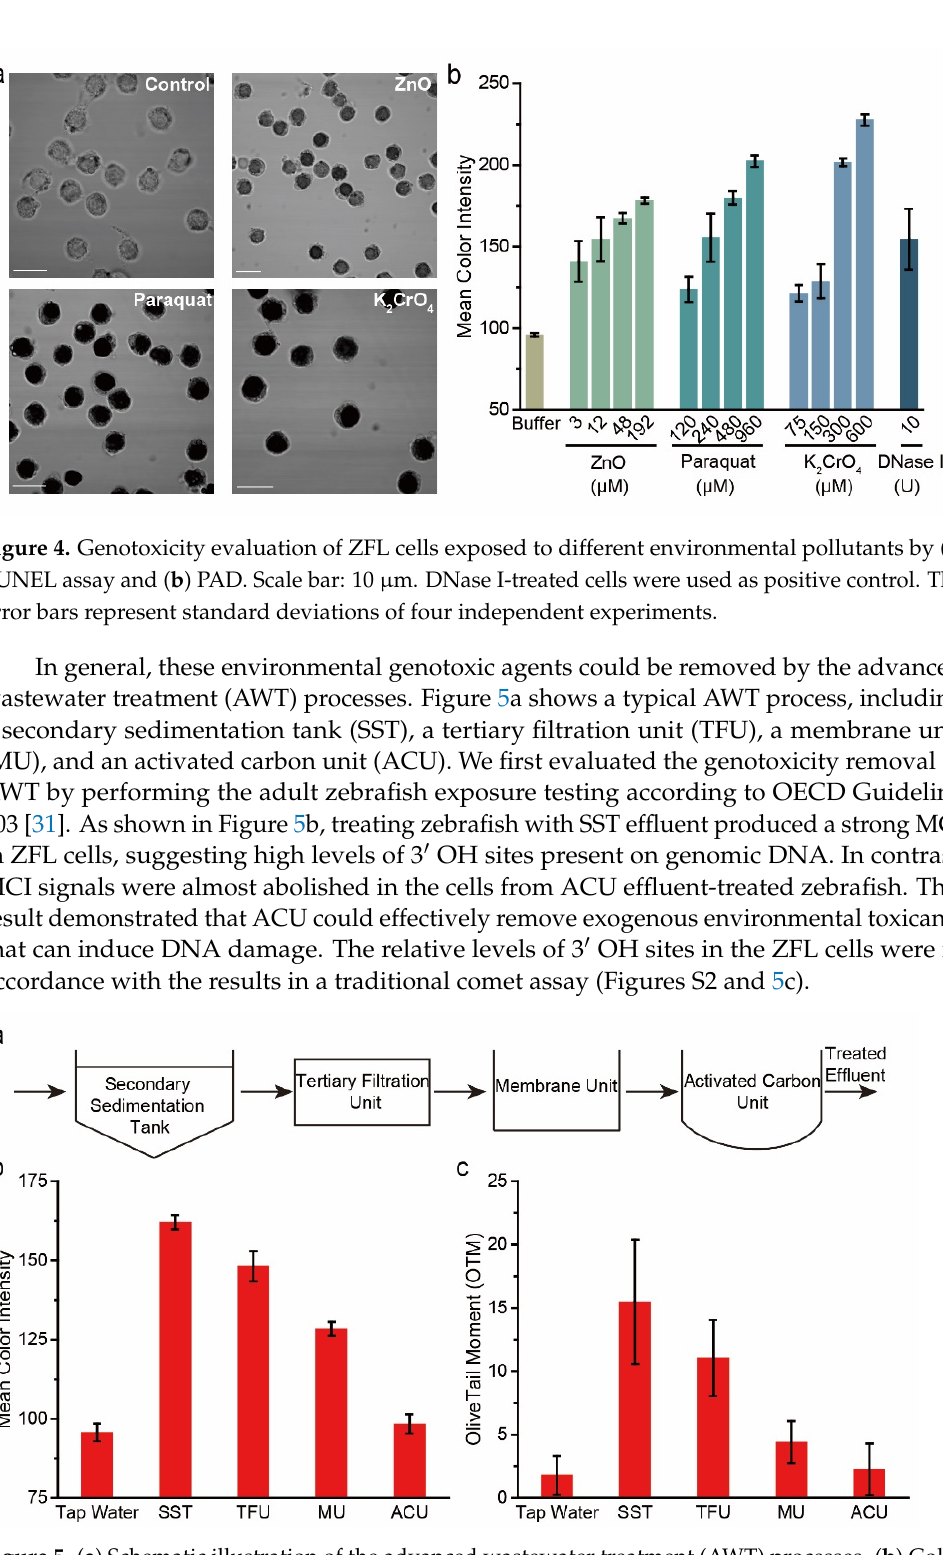
Figure 5. ( a ) Schematic illustration of the advanced wastewater treatment (AWT) processes. ( b ) Color intensity of PADs. ( c ) Comet assay. Each datum was calculated from at least 50 individual comets. ZFL cells from zebrafish were first treated with effluents from SST, TFU, MU, and ACU. De-chlorinated tap water was used as a control. The error bars represent standard deviations of four independent